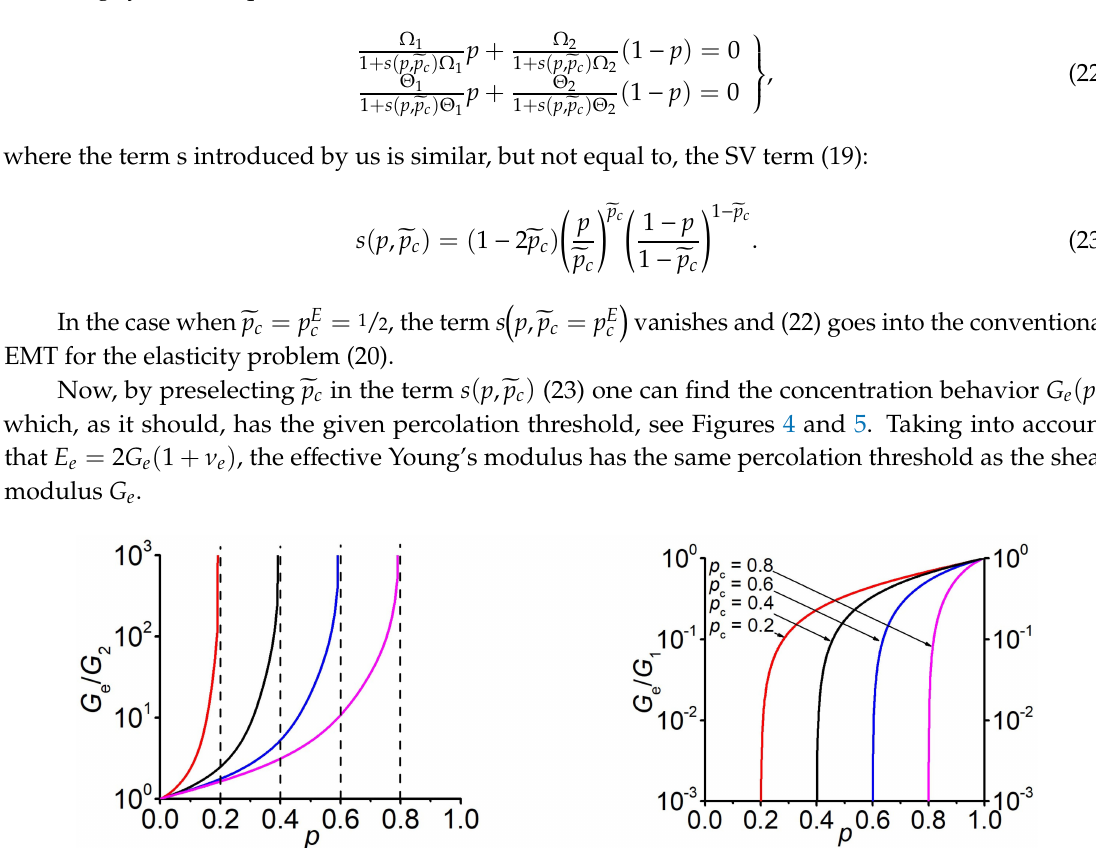
Figure 4. Concentration dependences of the e ff ective shear modulus G e at G 2 / G of the percolation threshold. ( a ) G 2 = 10 5 Pa, ν 2 = 0.49 and G 1 = ∞ . ( b ) G 1 = 10 11 Pa, ν 1 = 0.3 and G 2 = 0